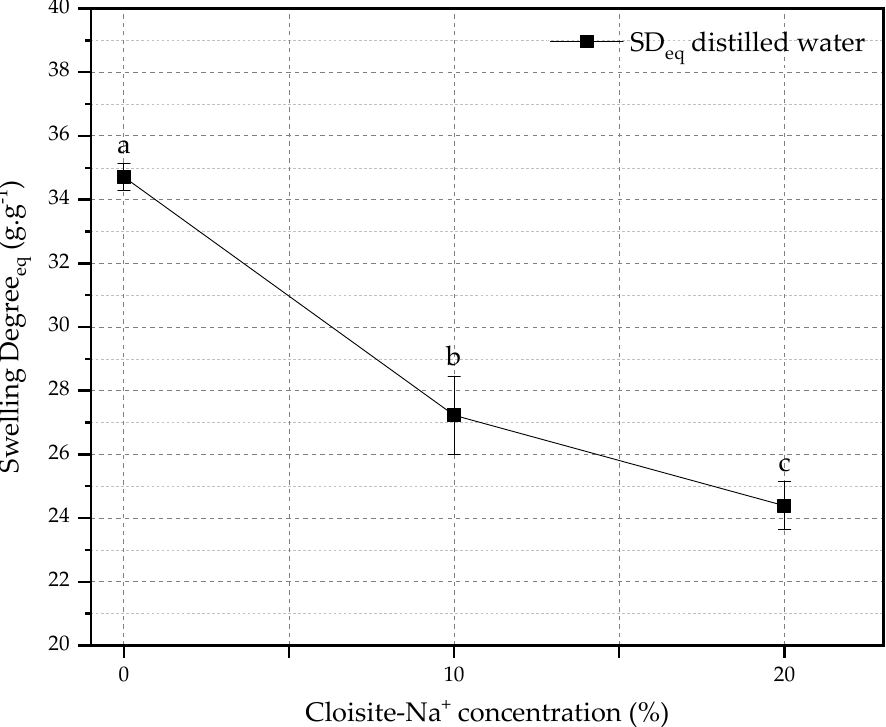
9 of 25 Figure 1. Swelling curves as a function of time for hydrogels with different Cloisite-Na + concentra- tion in distilled water. It is seen from Figure 1 that all hydrogels showed water absorption in the range of 24–32 (g·g −1 ) in distilled water. Also, the Cloisite-Na + interferes directly in this hydrophilic property because the higher its concentration, the lower hydrogels swelling degree, cor- roborating with reported by Aalaie et al. [54]. The authors verified that the equilibrium degree of swelling of the nanocomposites decreases with the increase of montmorillonite content because the free hydrophilic groups of the nanocomposite reduce with the Na + increases, decreasing the difference in the osmotic pressure between the matrix and the swelling medium and, consequently a retraction of the hydrogels with Cloisite-Na + [54]. In the first eight hours of testing, it was possible to observe an accelerated water ab- sorption, independently of the concentration of nanoclay, reaching the equilibrium con- ditions after 48 h. Similar behavior was also observed by Yenozawa et al. [55]. The results